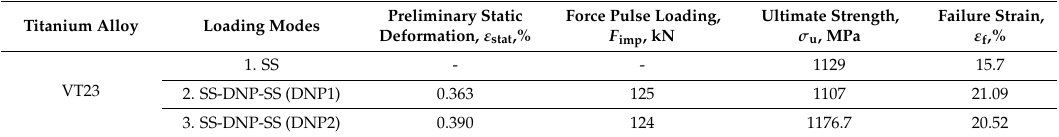
Table 2. Loading modes of alloy VT23 and its mechanical properties.